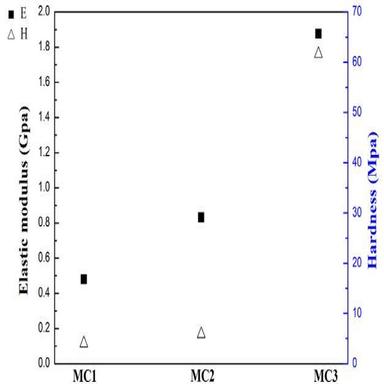
Elastic modulus (E) and hardness (H) of microcapsules with different shell composition.